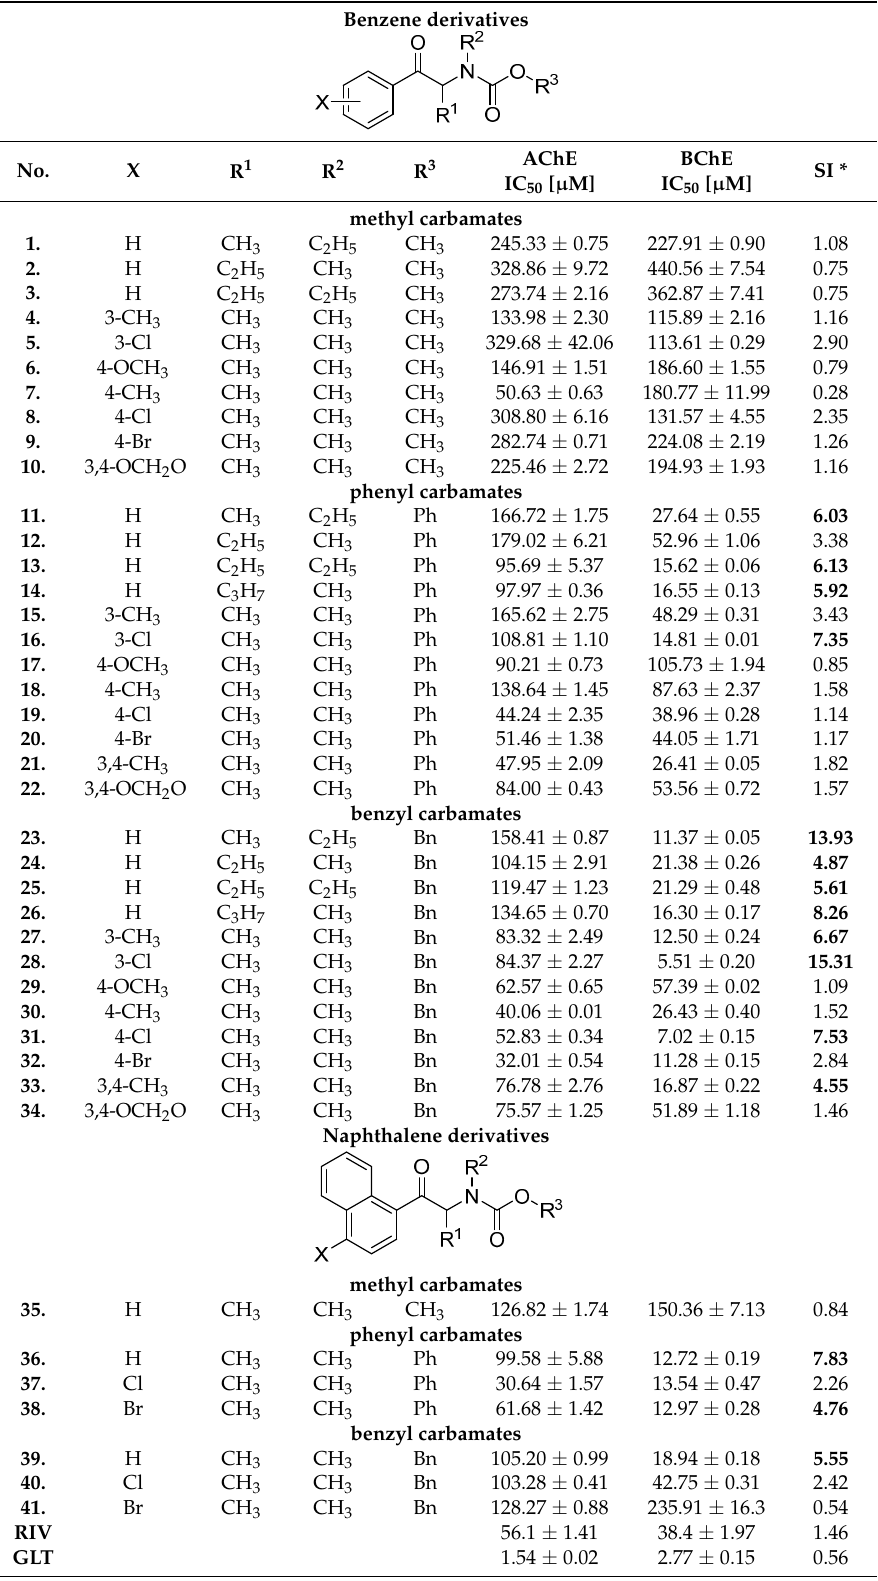
Table 1. Structures of the carbamate derivatives 1–41; in vitro AChE and BChE inhibition (IC 50 ) compared with the standards rivastigmine (RIV) and galanthamine (GLT). ChE inhibitions are expressed as the mean ± SD ( n = three experiments).